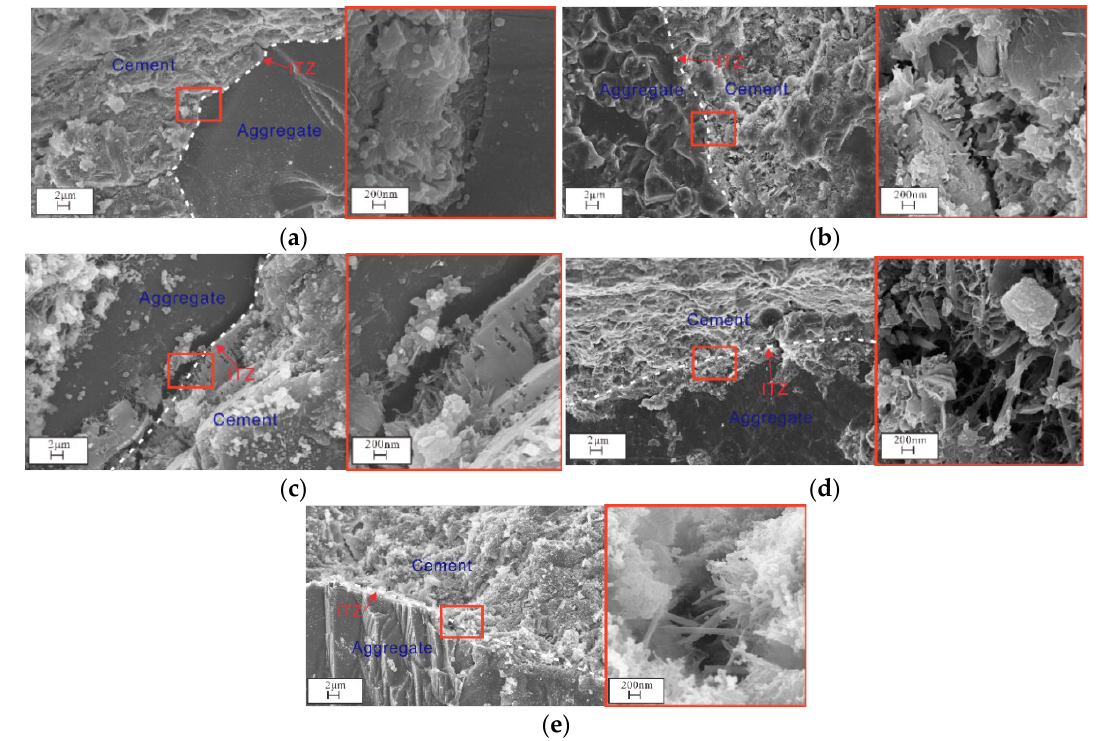
Figure 12. ITZ of samples after 360 d of erosion: ( a ) C; ( b ) CS0.2-M; ( c ) CS0.5-M; ( d )